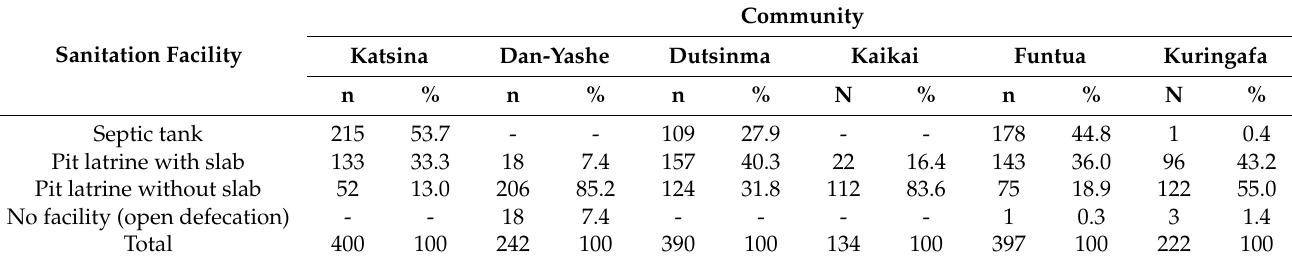
Table 7. Household sanitation facilities across the sampling